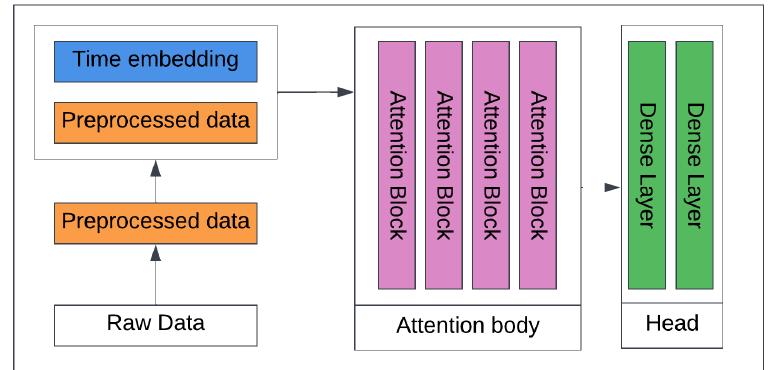
Figure 11. The Transformer architecture used to predict blood glucose